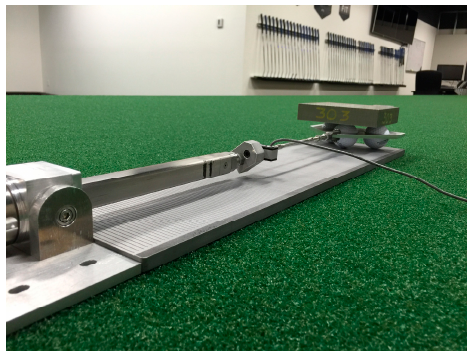
Figure 2. Experimental setup used to measure coefficient of friction between golf ball and surface.